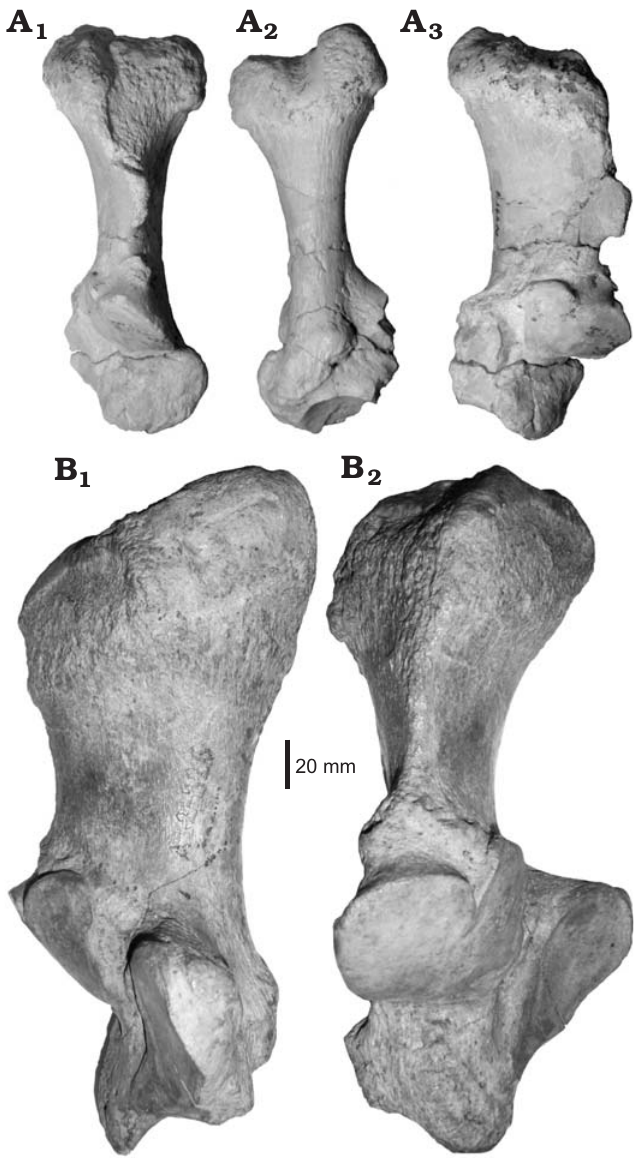
Fig. 7. Homalodotheriid notoungulate Asmodeus from Argentina. A . Asmo- deus petrasnerus Seoane and Cerdeño, 2014, from Quebrada Fiera, Men- doza; Deseadan SALMA (late Oligocene), MCNAM-PV 4958, left calca- neum, anterior (A 1 ), posterior (A 2 ) and medial (A 3 ) views. B . Asmodeus osborni Ameghino, 1894 from Santa Cruz; Deseadan SALMA (late Oligocene), MACN A 12327, holotype, right calcaneum, medial (B 1 ) and anterior (B 2 )